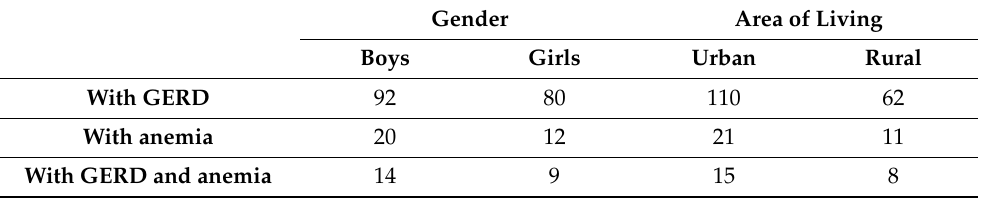
Table 8. Distribution of cases according to gender and area of